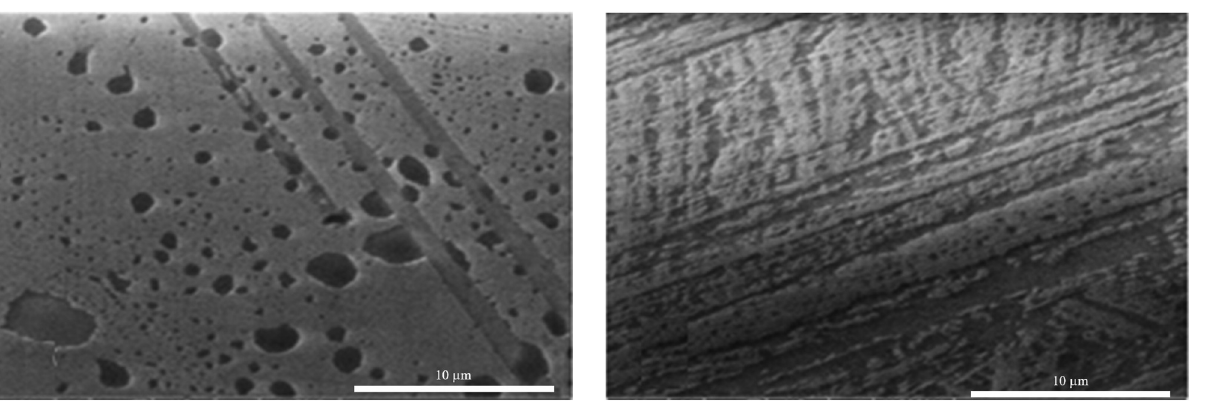
Figure 15: Uncoated alumina femoral head tested in the absence of SF ( dry condition )